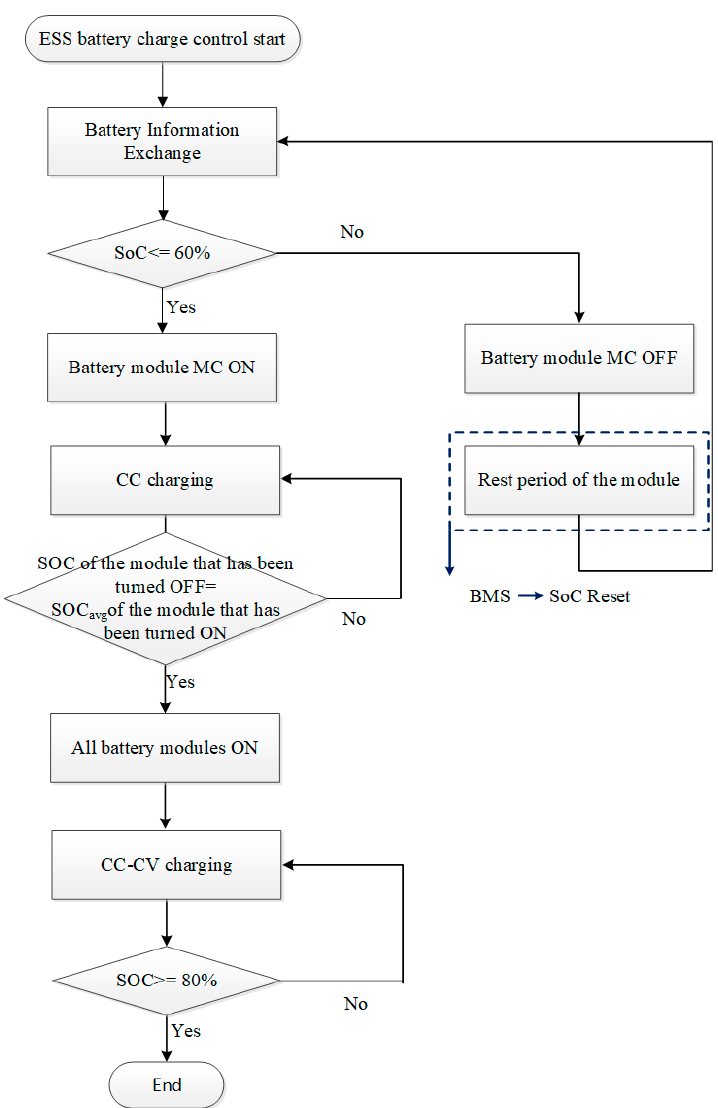
Figure 9. Proposed power conversion system (PCS) charge control method algorithm.